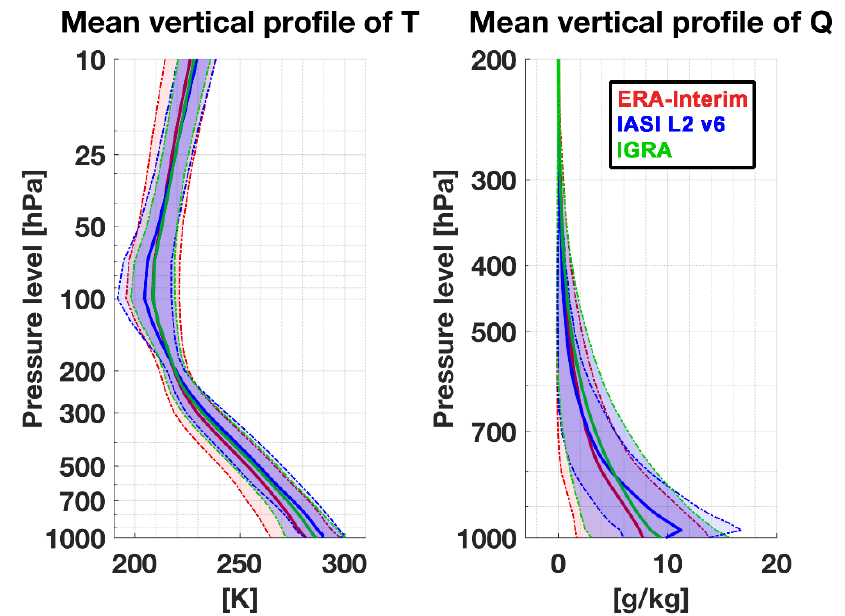
Figure A1. ERA-Interim, IASI L2 v6, and IGRA T ( left ) and Q ( right ) mean vertical profiles ( solid ) and standard deviation (dashed lines and shaded areas).